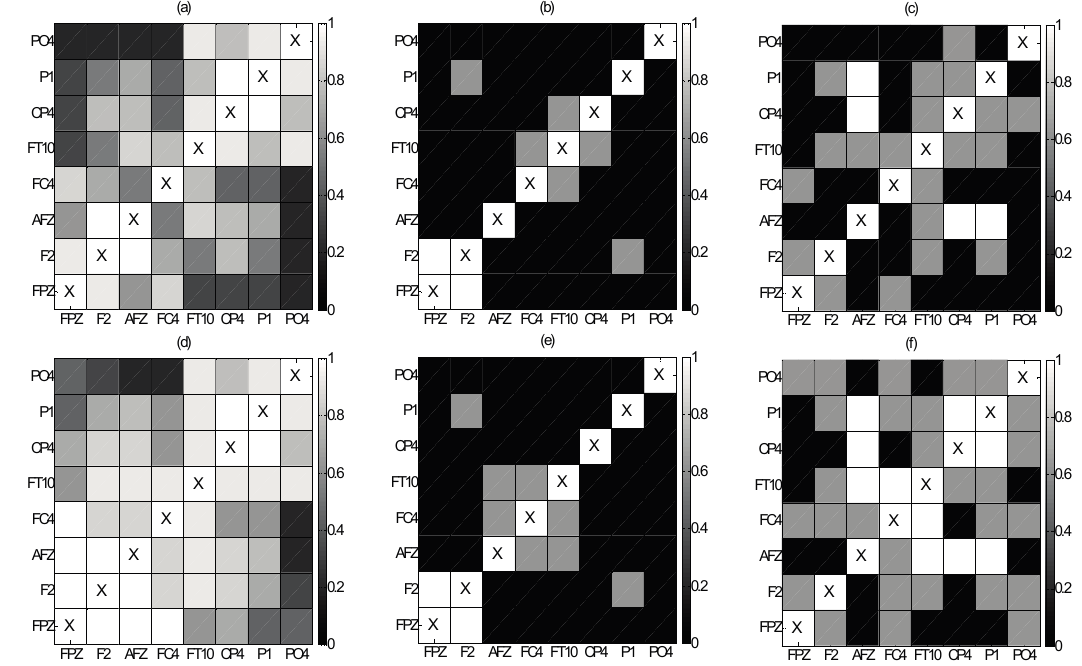
Figure 3. For the episode in Figure 2, the average of the binary connections constructed by r over 10 binary networks for 10 s of preED in ( a ), and the method THRESH and (0) ji accordingly 2 s of preTMS in ( b ) and postTMS in ( c ). In ( d – f ), the same results are r displayed but for the method FDR-R and (0) ji